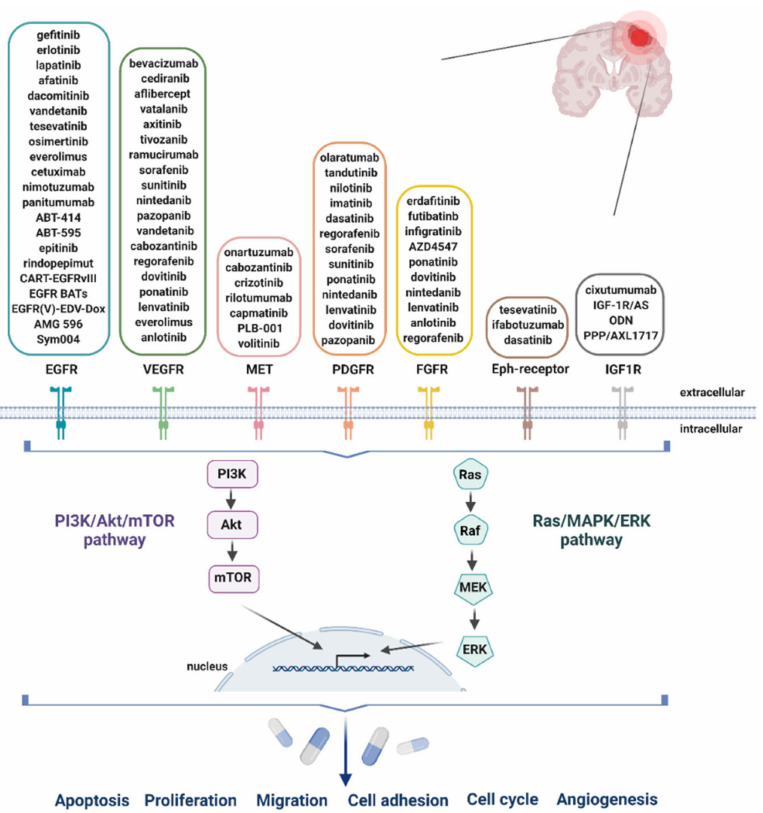
Figure 1. Overview of receptor tyrosine kinase inhibitors (RTKI) for the treatment of glioblastoma